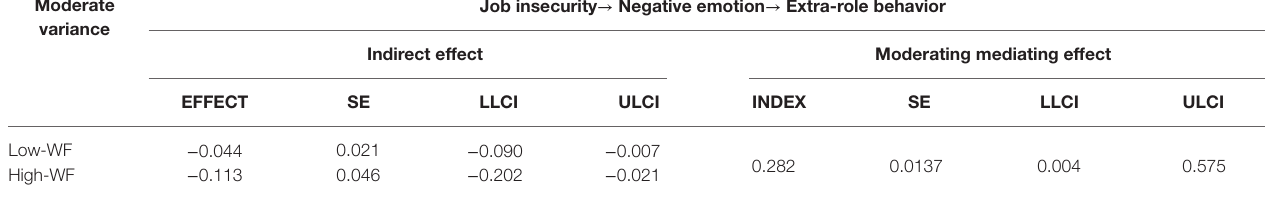
TABLE 4 | Moderated mediating